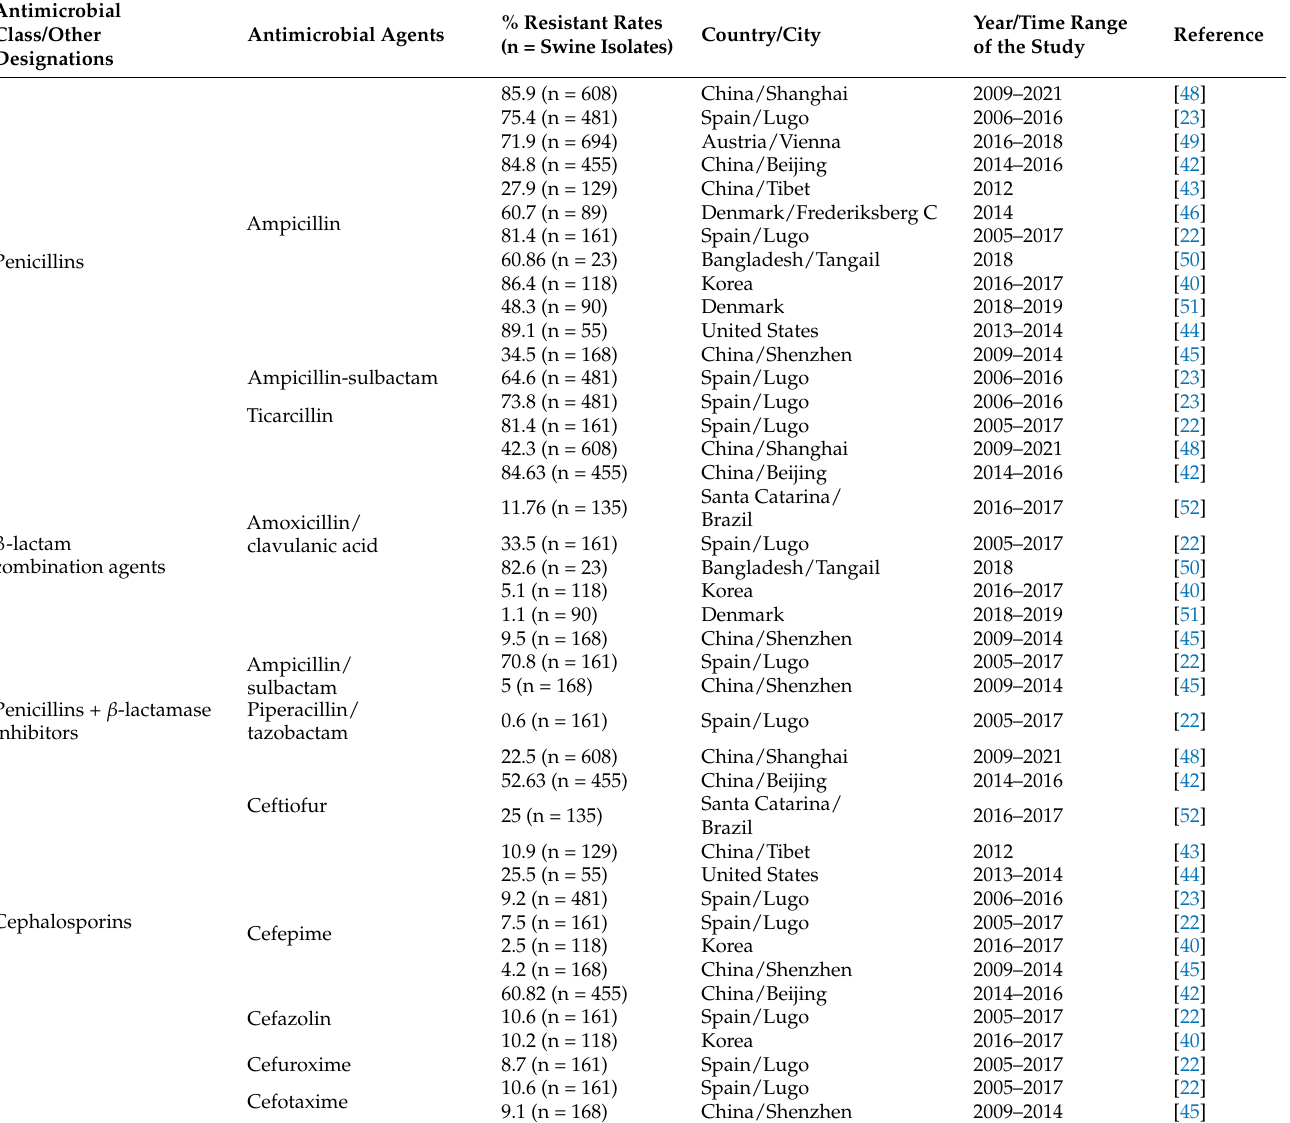
Antimicrobial Class/Other Antimicrobial Agents